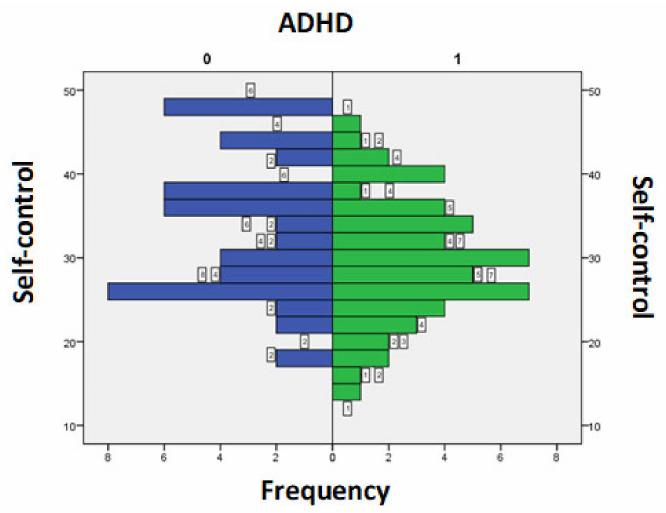
Figure 1. Score for Self-control section according to the presence/absence of ADHD